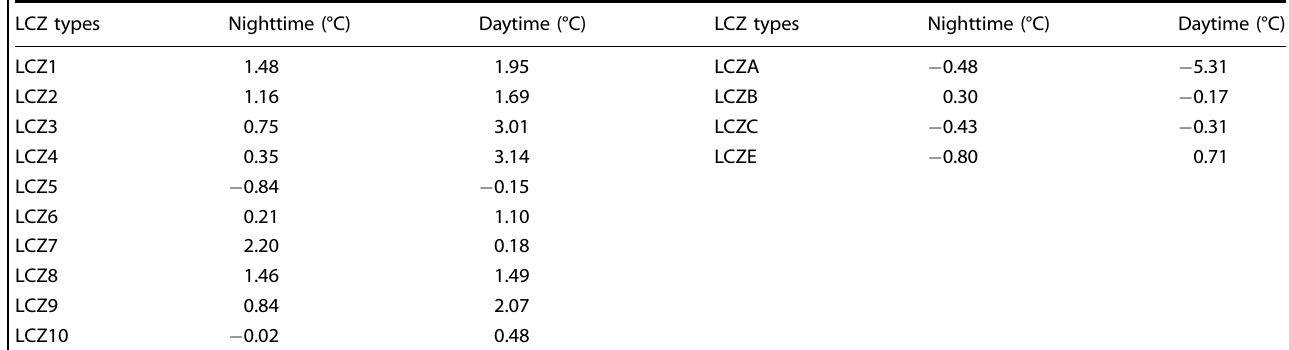
Table 2. Summary of UHII in each LCZ in Shenzhen.